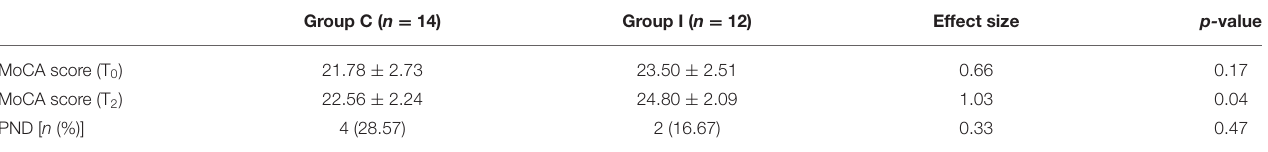
TABLE 2 | Neuropsychological assessment and incidence of PND.